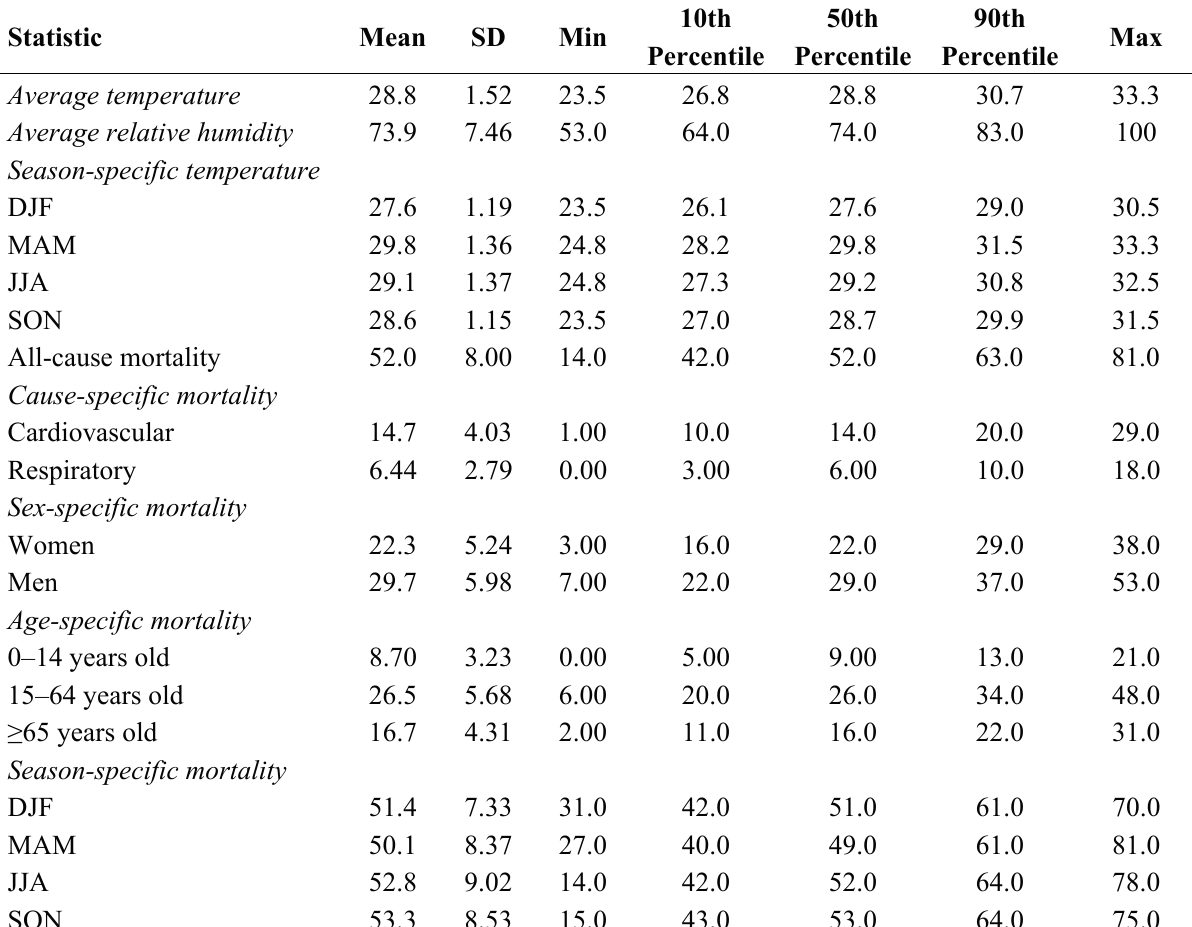
Table 1. A summary of the meteorological and mortality statistics in Manila city during